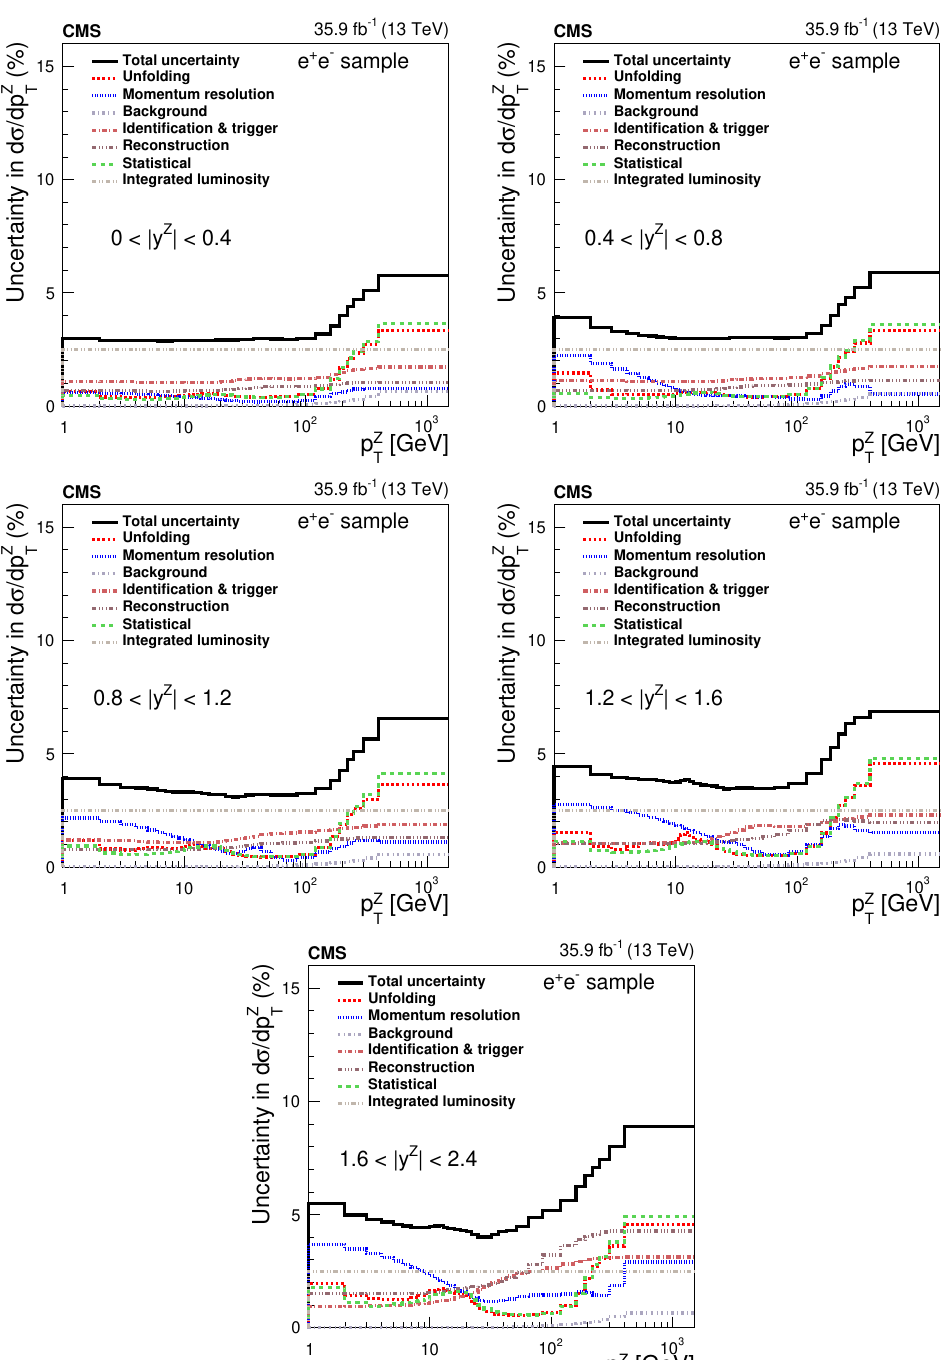
Figure 4 . The relative statistical and systematic uncertainties from various sources for the absolute double-di(cid:11)erential cross section measurements in bins of p Z for the 0 : 0 < j y Z j < 0 : 4 bin (upper T left), 0 : 4 < j y Z j < 0 : 8 bin (upper right), 0 : 8 < j y Z j < 1 : 2 bin (middle left), 1 : 2 < j y Z j < 1 : 6 bin (middle right), and 1 : 6 < j y Z j < 2 : 4 bin (lower) in the dielectron (cid:12)nal